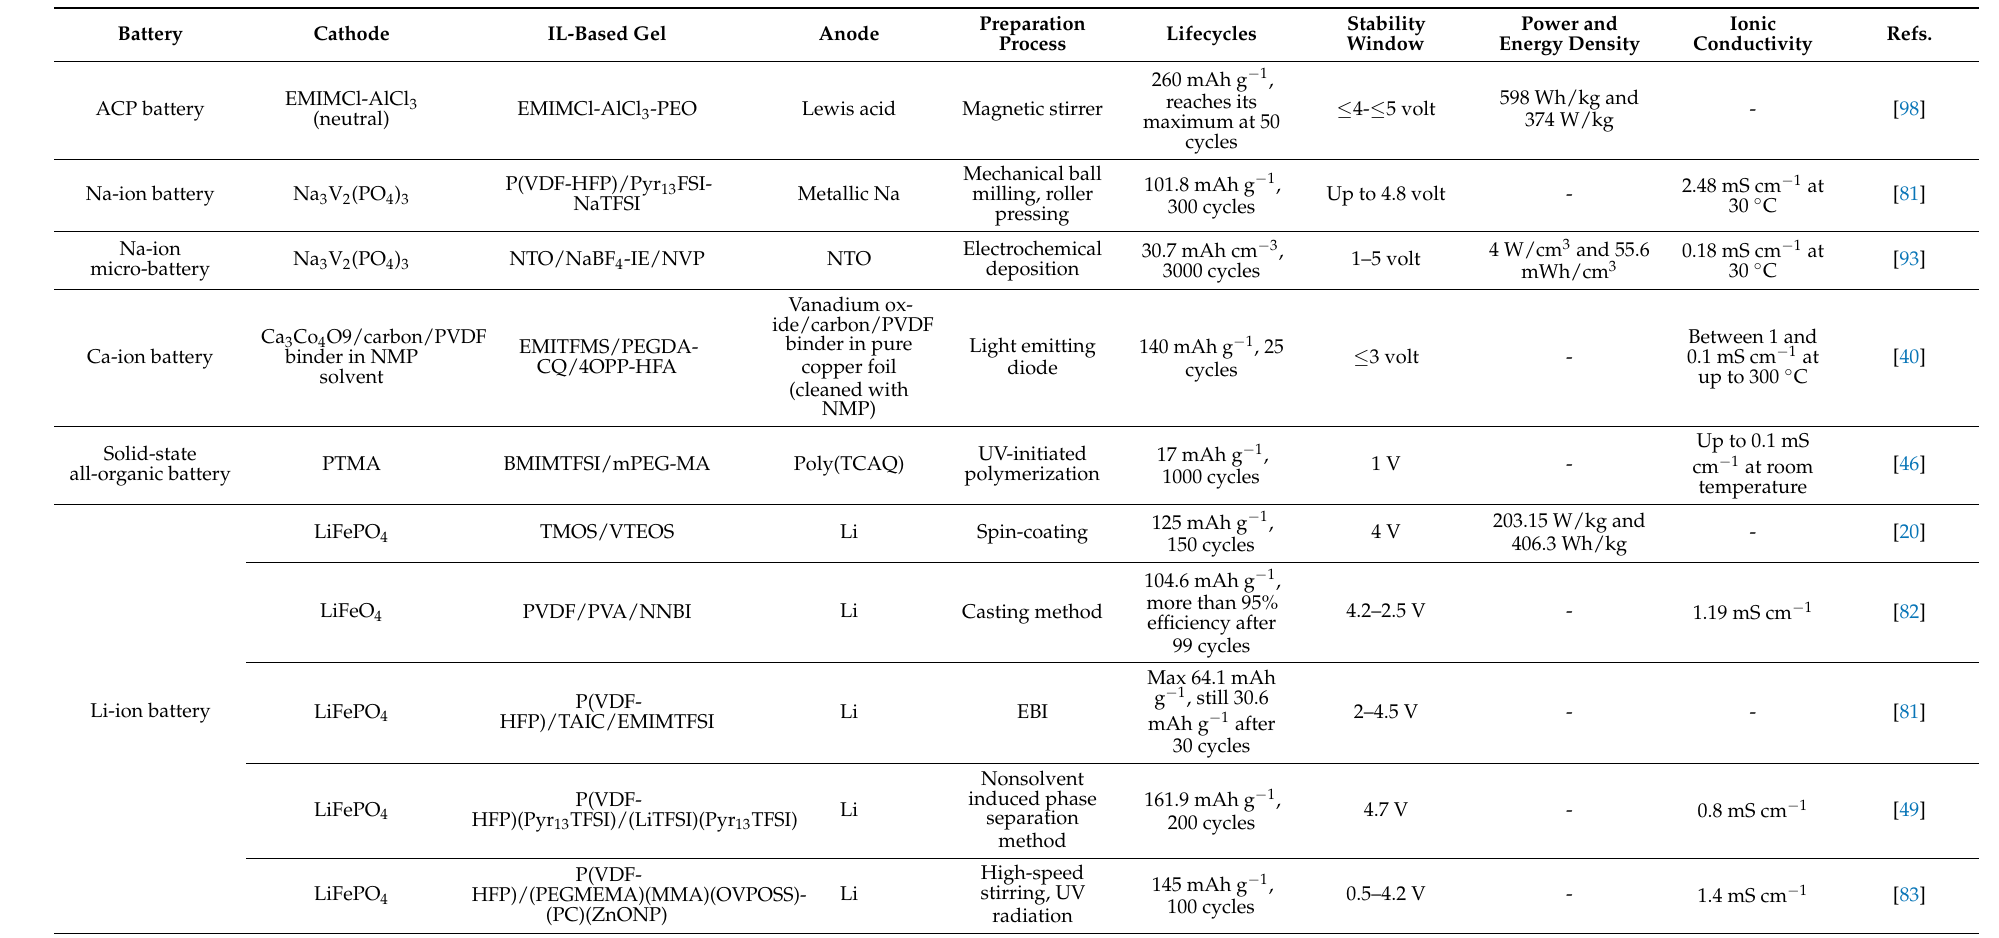
Table 2. Electrochemical performances of IL-based gel electrolytes for applications in